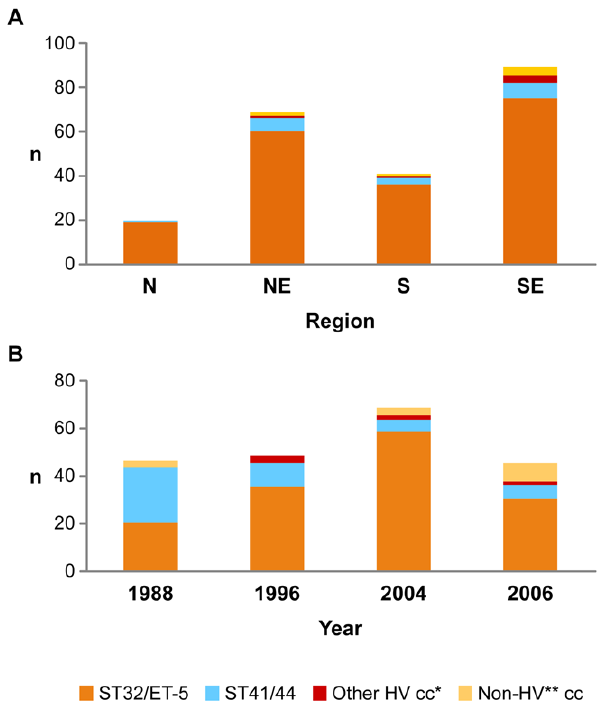
Figure 1. Distribution of clonal complexes by year and region in Brazil. 1a. Clonal complex by Region, Brazil 2004. 1b. Clonal complex by year, Sa˜o Paulo, Brazil, 1988–2004. Footnote for Fig. 1a and 1b: *Other Hypervirulent (HV) cc=ST-8/A4, ST-23/A3; ST-11/ET-37.